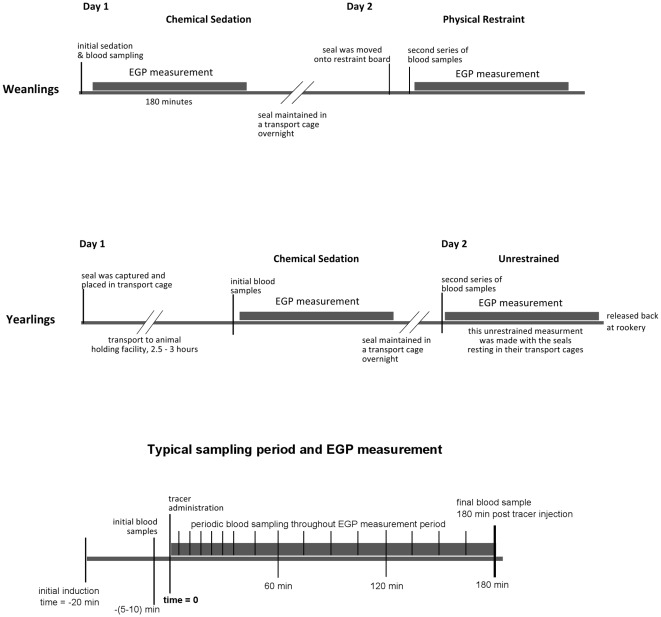
Summary of the treatment procedures used in this study.The measurement of endogenous glucose production (EGP) was performed by administering [6-3H]glucose as a tracer and periodically drawing blood samples over 180 minutes. Animals in the “field sedated” study group were all measured at the rookery. Weanlings and yearlings in the “handling manipulation” group were each measured twice over two consecutive days. Weanlings were studied at the rookery while yearlings were transported to an animal holding facility for study.